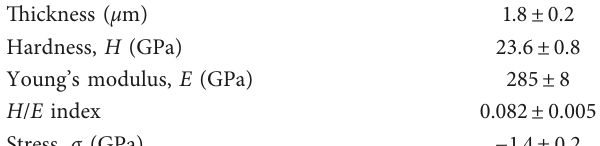
Table 1: The properties of CrN coatings on 42CrMo4 steel.